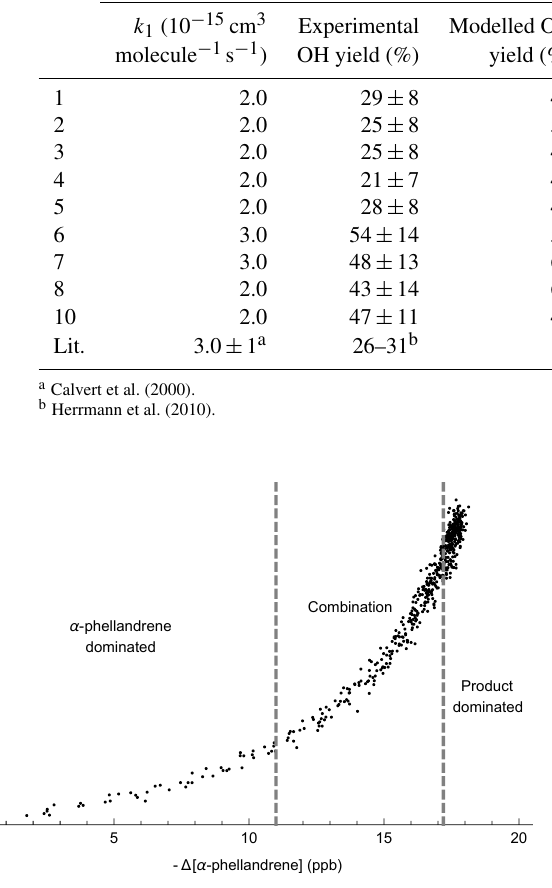
Table 5. Measured and modelled OH radical yields and modelled rate constants for α -phellandrene ozonolysis experiments. α -phellandrene